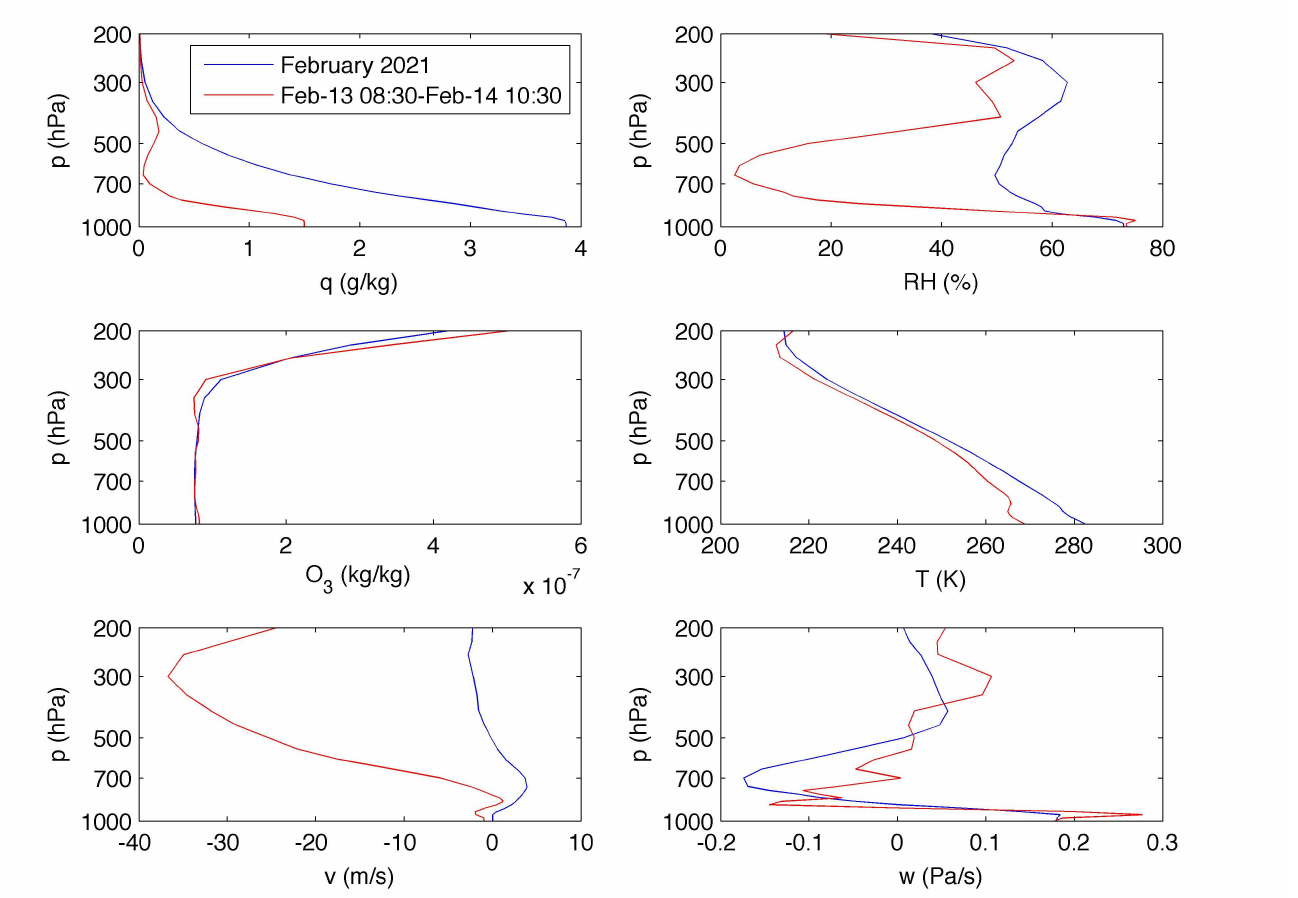
Figure 4. ERA5 profiles for specific humidity q, relative humidity RH, ozone mass mixing ratio O 3 , temperature T, meridional wind v (positive values = northward) and vertical wind w (positive values = downward). The red profiles are for the short time period when the IWV depression occurred (for 13 February 2021, 8:30 UT–14 February 2021, 10:30 UT). The blue profiles are for the averages of the complete February